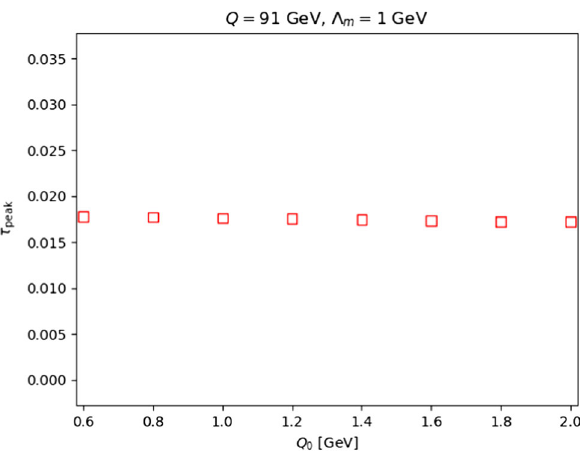
Fig. 4 Position of the peak of the thrust distribution as a function of the shower cutoff Q 0 when the soft model shape function is modified accordingly. Displayed is a plot for Q = m Z with (cid:3) m = 1GeV